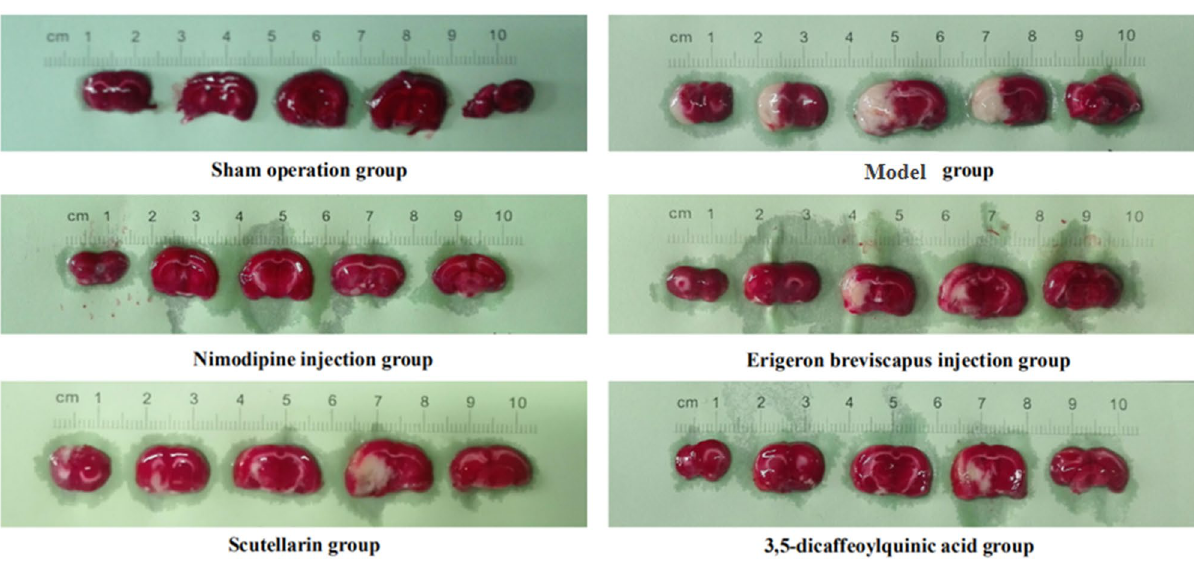
Figure 4. E. breviscapus treatment reduces infarct size in rats: ① the pale region of the midbrain is the cerebral infarction area; and ② selected the brain slices of one typical animal in each